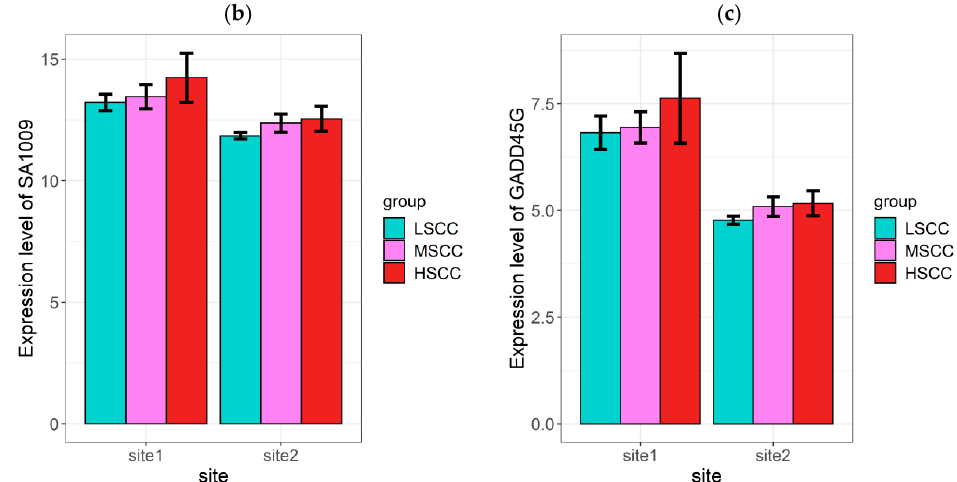
Figure 8. Correlation analysis between DEGs and differentially abundant taxa. ( a ) Associations between differentially abundant genera and the top discriminating DEGs identified in both sites using linear mixed model (‘*’stands for p < 0.05, ‘**’stands for p < 0.01). ( b,c ) Rlog-transformed read counts of S100A9 and GADD45G in different groups.